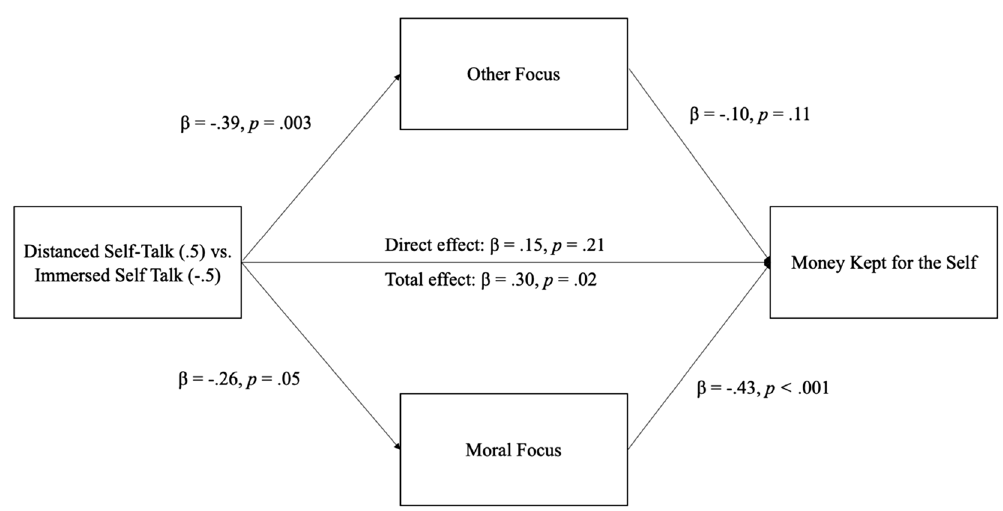
Figure 1. Mediation model from Study 3. Participants using distanced (vs. immersed) self-talk thought less about other people and less about moral principles. Decreases in moral-focus (but not other-focus) mediated the finding that distanced (vs. immersed) self-talk was associated with more money kept for the self. All β values represent partially standardized coefficients, consistent with recommendations from Hayes (2017) to use partially standardized coefficients with dichotomous X